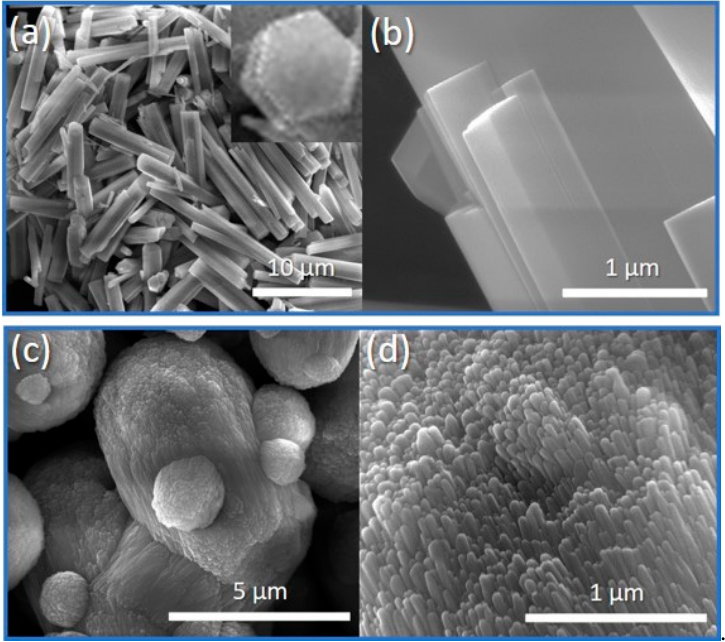
Figure 2. SEM images of ( a , b ) CTA + -offretite and ( c , d ) TMA + -offretite zeolites under different magnifications.